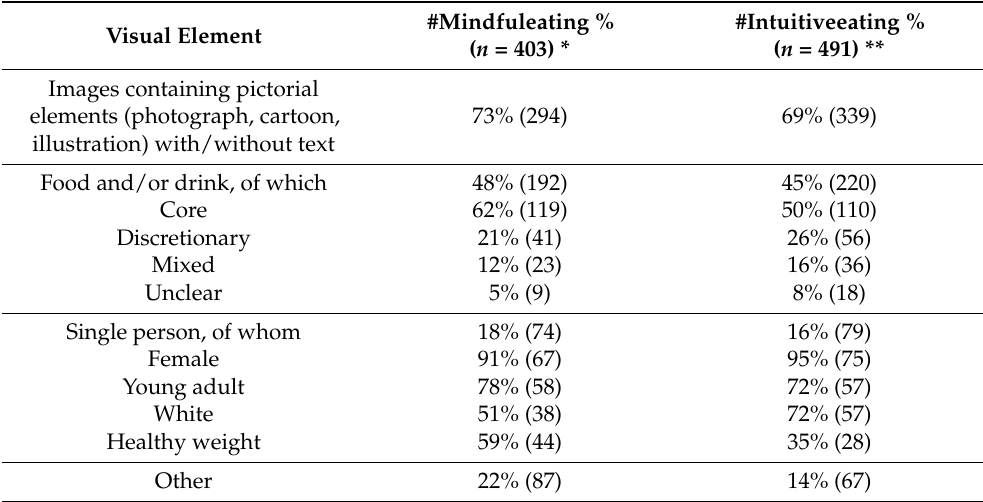
Table 1. Summary of pictorial content visible under #mindfuleating and #intuitiveeating, as percent- age of total